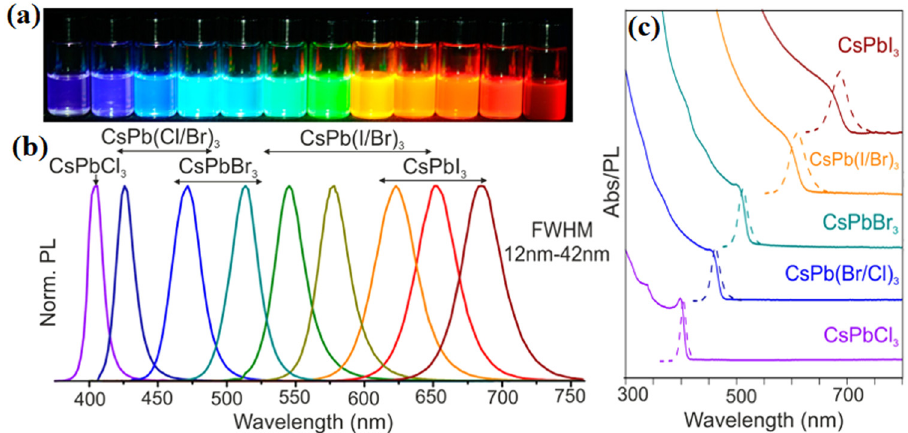
Figure 7: ( a ) The luminescence color of the perovskite solution under UV light ( λ = 365 nm ) . ( b ) The PL fl uorescence peak position change of the corresponding component ( except for the CsPbCl 3 excitation wavelength of 350 nm, the rest are all 400 nm ) . ( c ) The absorption spectrum of the corresponding component. Reproduced with permission from ref. [ 72 ] . Copyright 2015, American Chemical